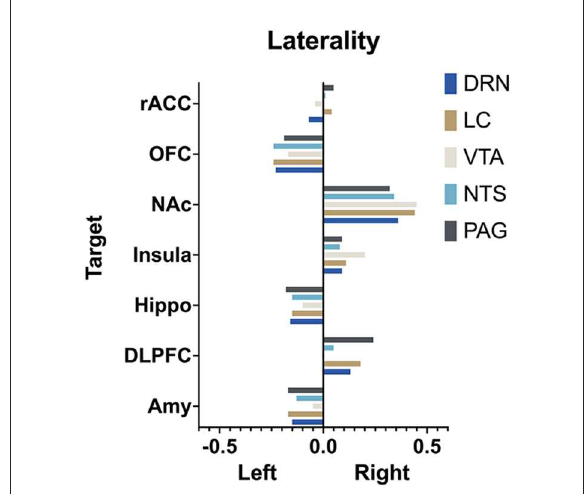
FIGURE9 Laterality. Arbitrary measure of laterality by seed nuclei. (Left) is set as negative and right as positive. More extreme values indicate greater difference in mean connectivity between (left) and (right)